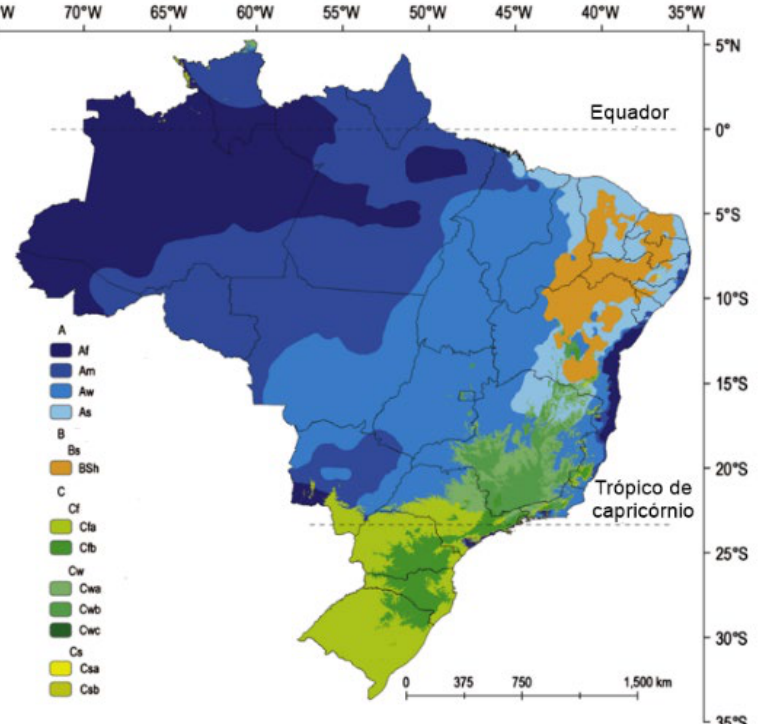
Figure 3. Brazil climate classification in the Köpper-Geiger system [18]